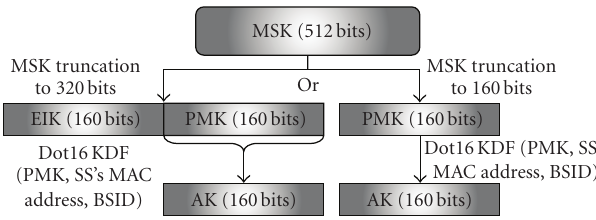
Figure 14: AK derivation with EAP authentication.